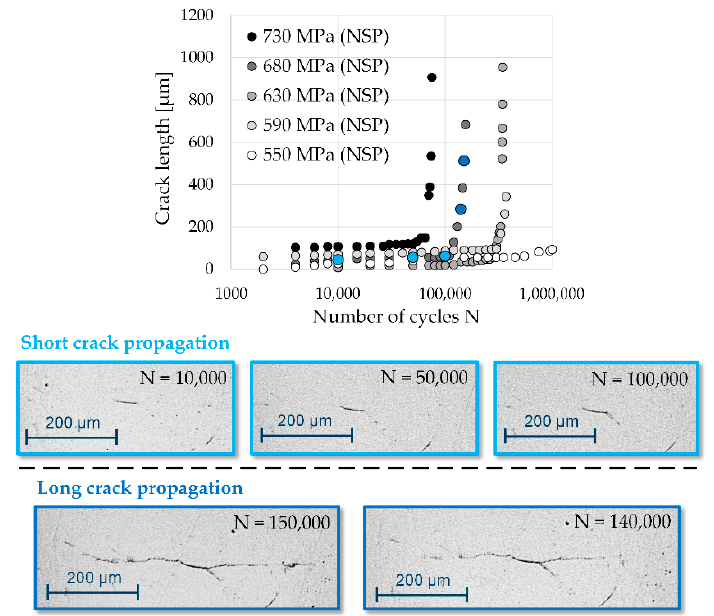
Figure 13. Crack length of NSP samples as a function of the number of cycles for different stress amplitudes and CLM images of the fatal crack development (marked in blue) divided into short crack propagation and long crack propagation, at Δσ /2 = 680 MPa, for selected cycle numbers.